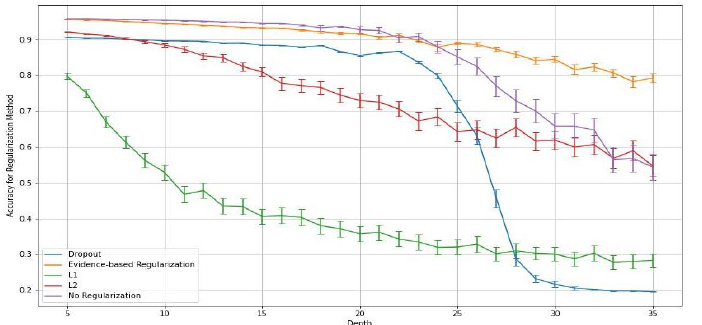
Figure A1. Training accuracy (and standard error) for different regularization methods for a network with width = 10.